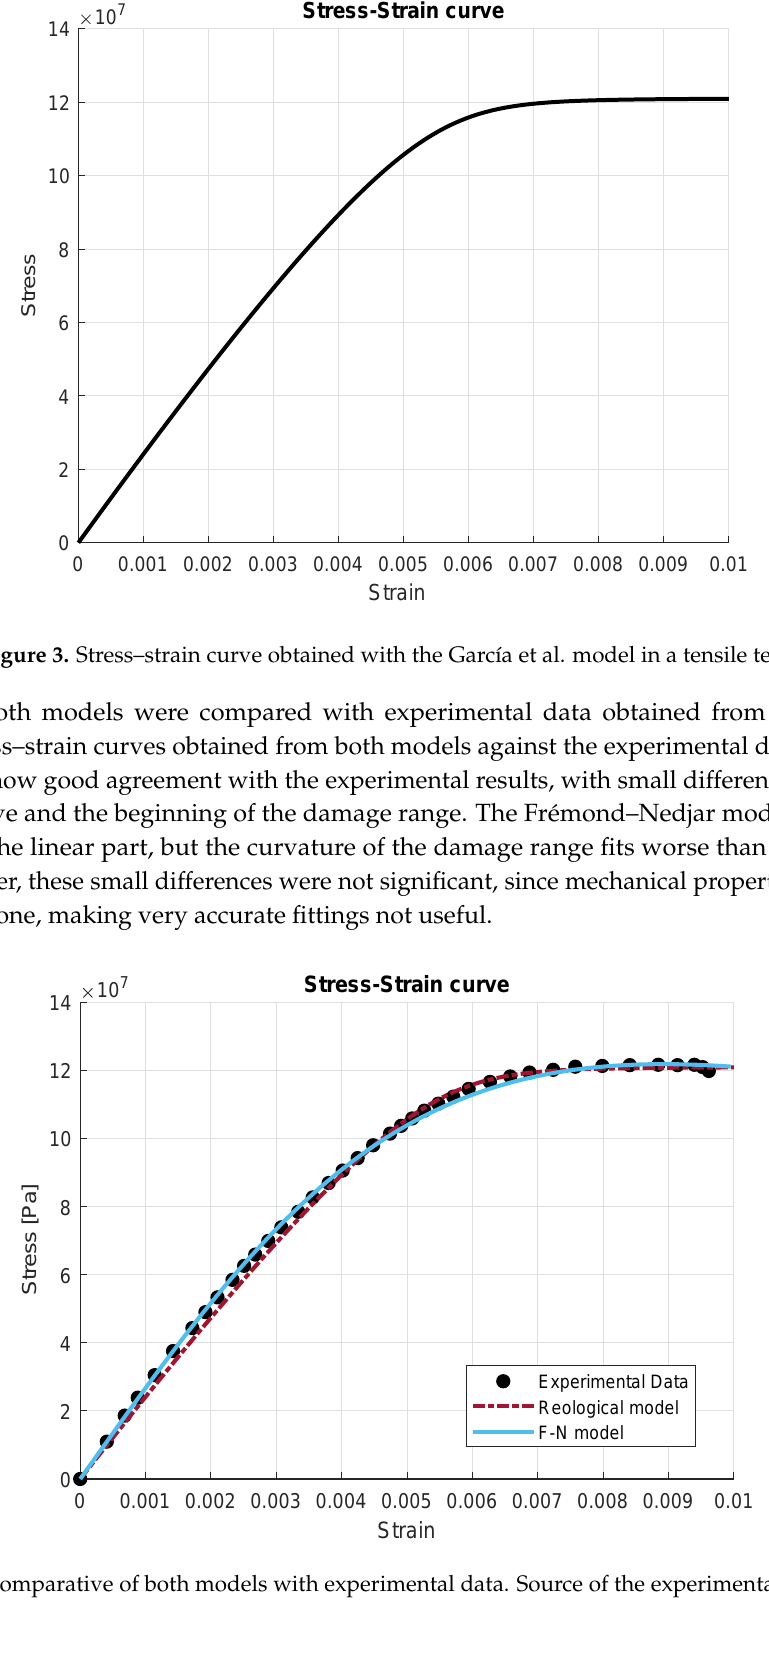
Figure 4. Comparative of both models with experimental data. Source of the experimental data: [18].